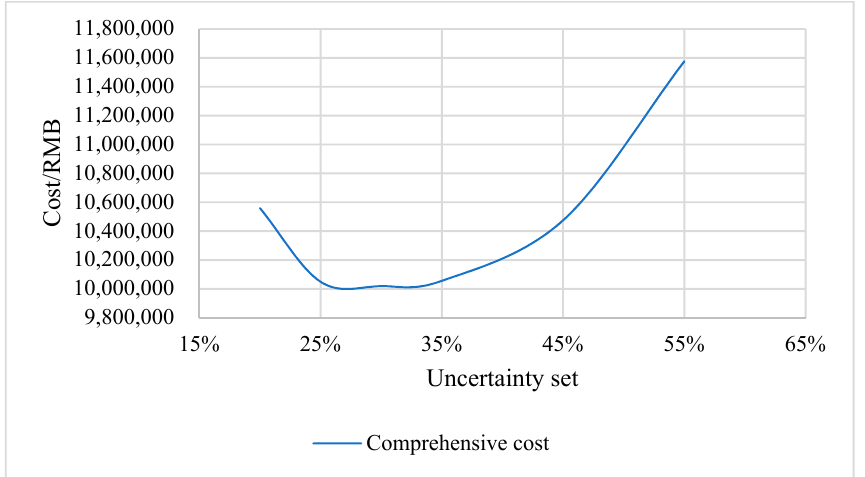
Figure 6. Comprehensive costs under different uncertainty sets. Table 3. Optimization results of uncertain sets.